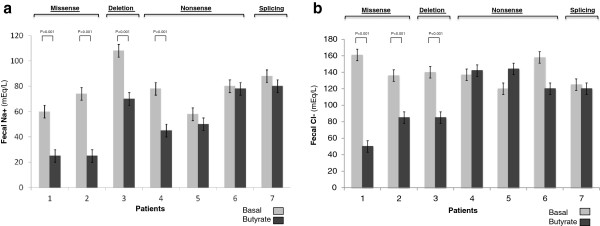
Fecal sodium (a) and chloride concentration (b) in children with congenital chloride diarrhea treated with butyrate. Box and bar represent median and min-max range, respectively.